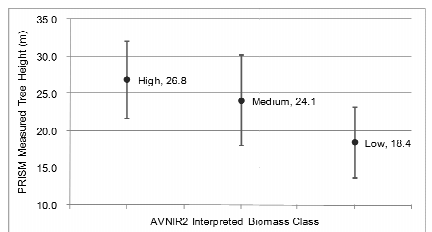
Figure 6 PRISM measured tree h eight and